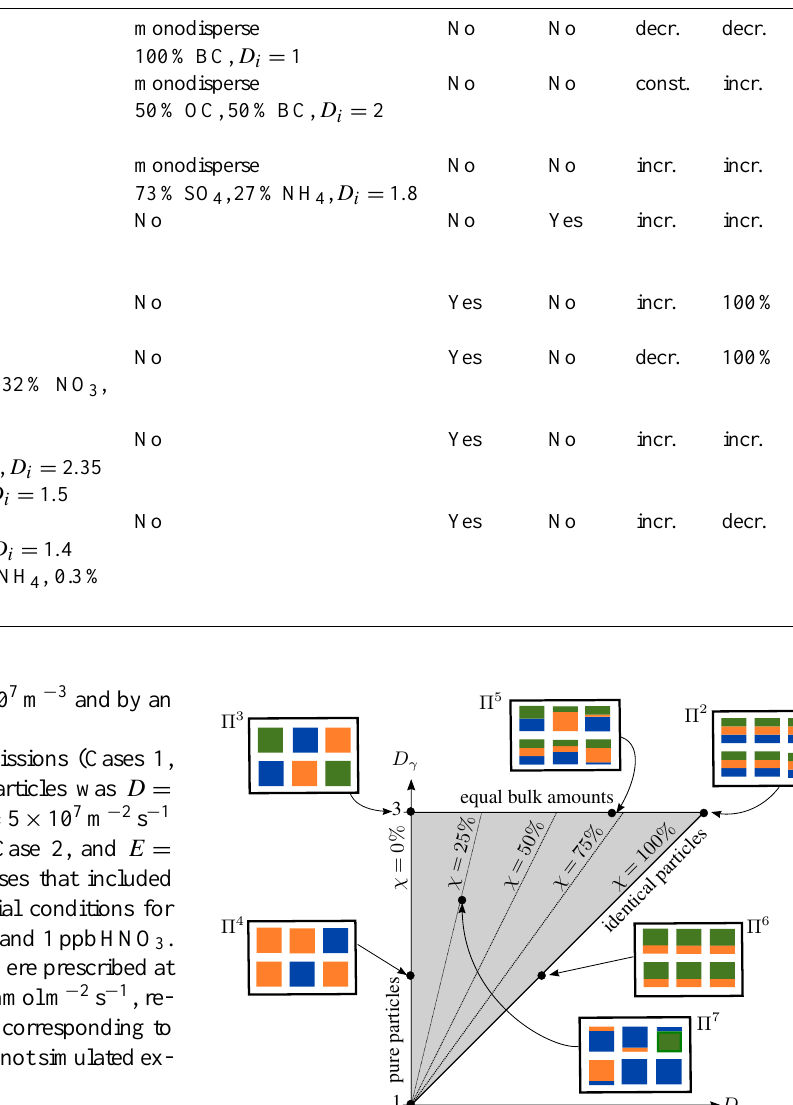
const. incr. Fig. 24: Diversity and mixing state evolution for BC- containing particles in the urban plume case. (a) Distribution of per-particle diversity D i as a function of time. (b) Time series of average particle diversity D ↵ , population diversity D  , and the mixing state index  .